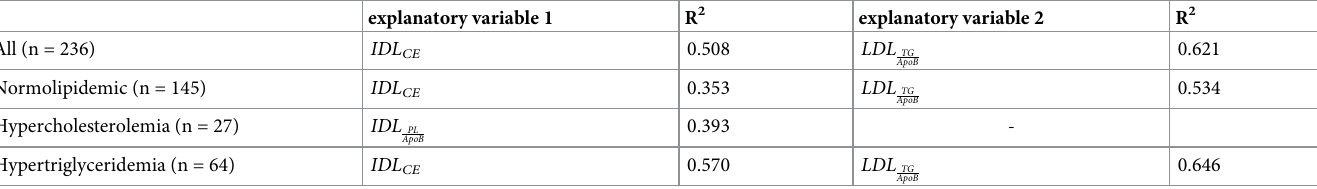
Table 1. Stepwise linear multiple regression on ApoB in